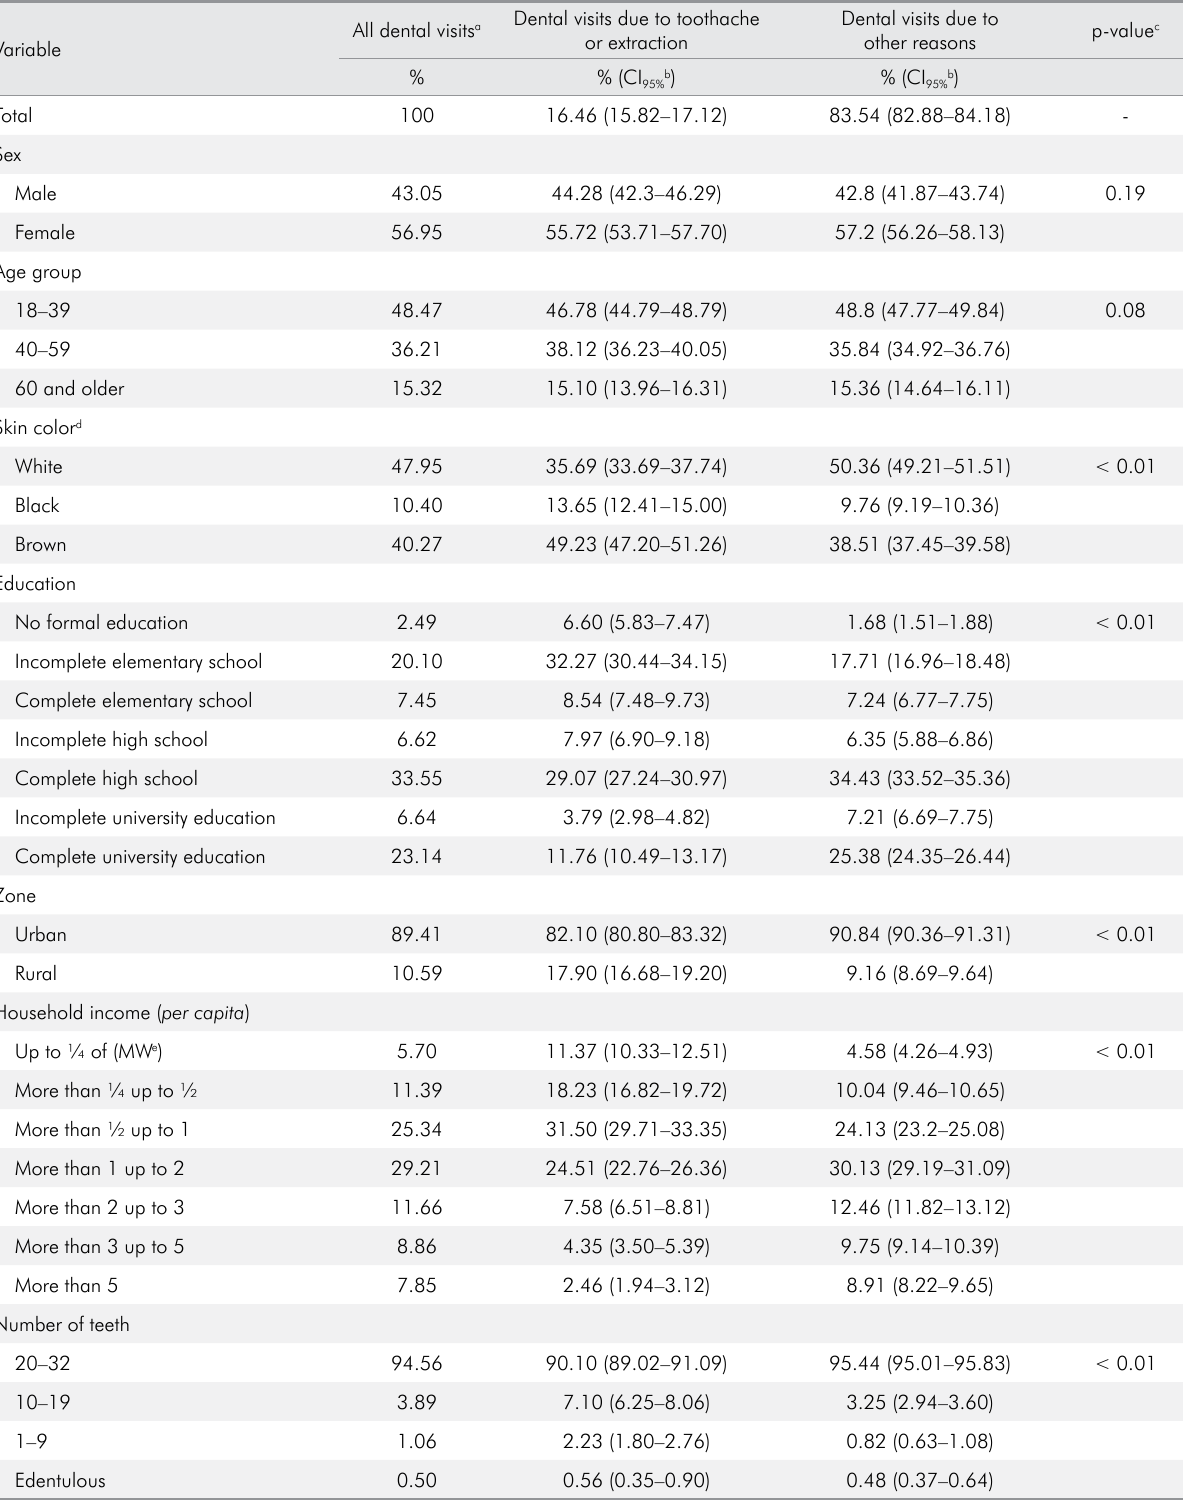
Table 2. Distribution (%) of dental visits in the year prior to the data collection due to toothache or tooth extraction compared with dental visits due to other reasons. National Health Survey (PNS),